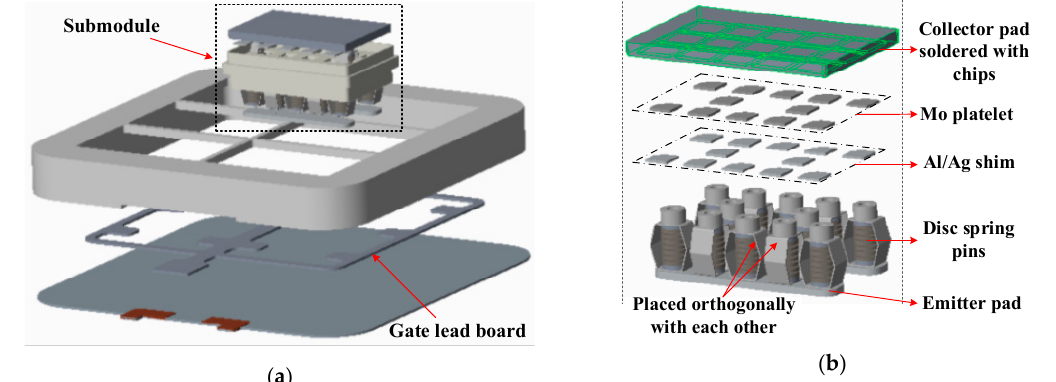
Figure 2. 3D explosion graph of a press-pack IGBT module: ( a ) Exploded view of the whole press-pack IGBT module; ( b ) exploded view of a single press-pack submodule.